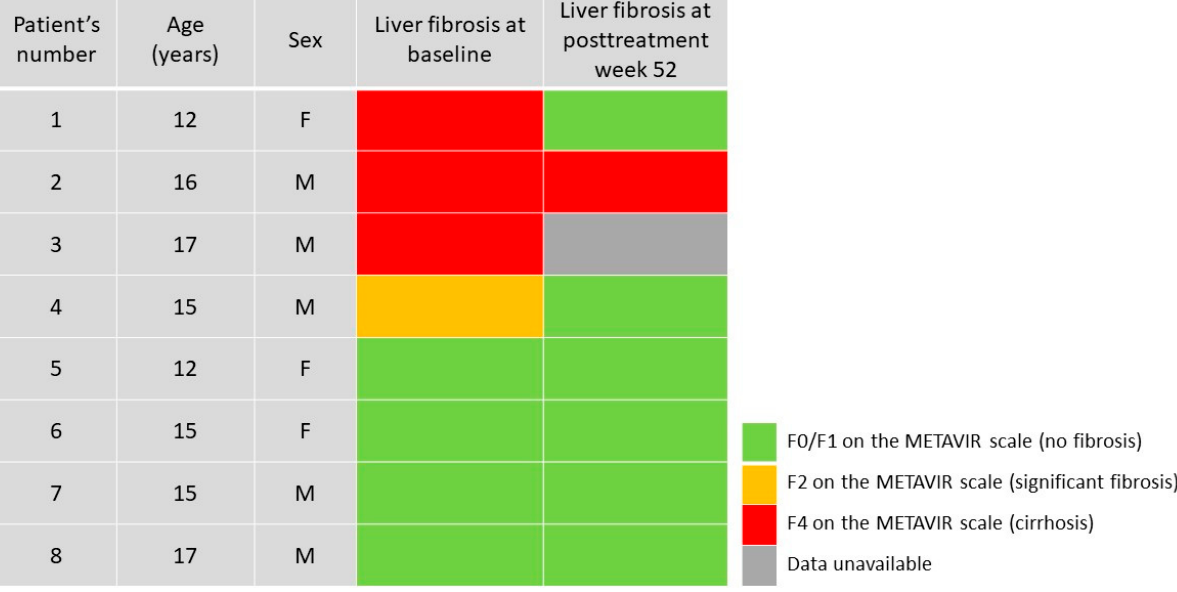
Figure 2. Stages of liver fibrosis evaluated by transient elastography at baseline and one-year after the end of treatment with ledipasvir/sofosbuvir in 8 patients. Each row represents one patient. F—female; M—male.